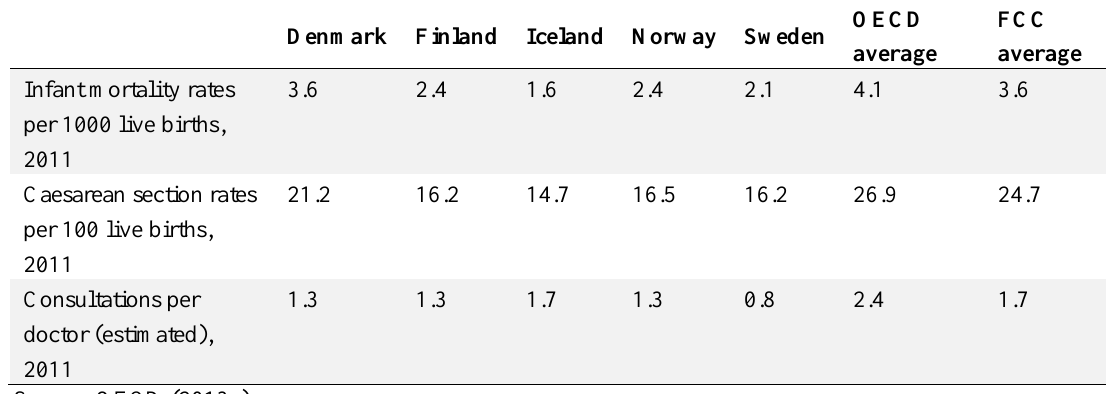
Indicators of exceptional circumstances in the Nordic countries